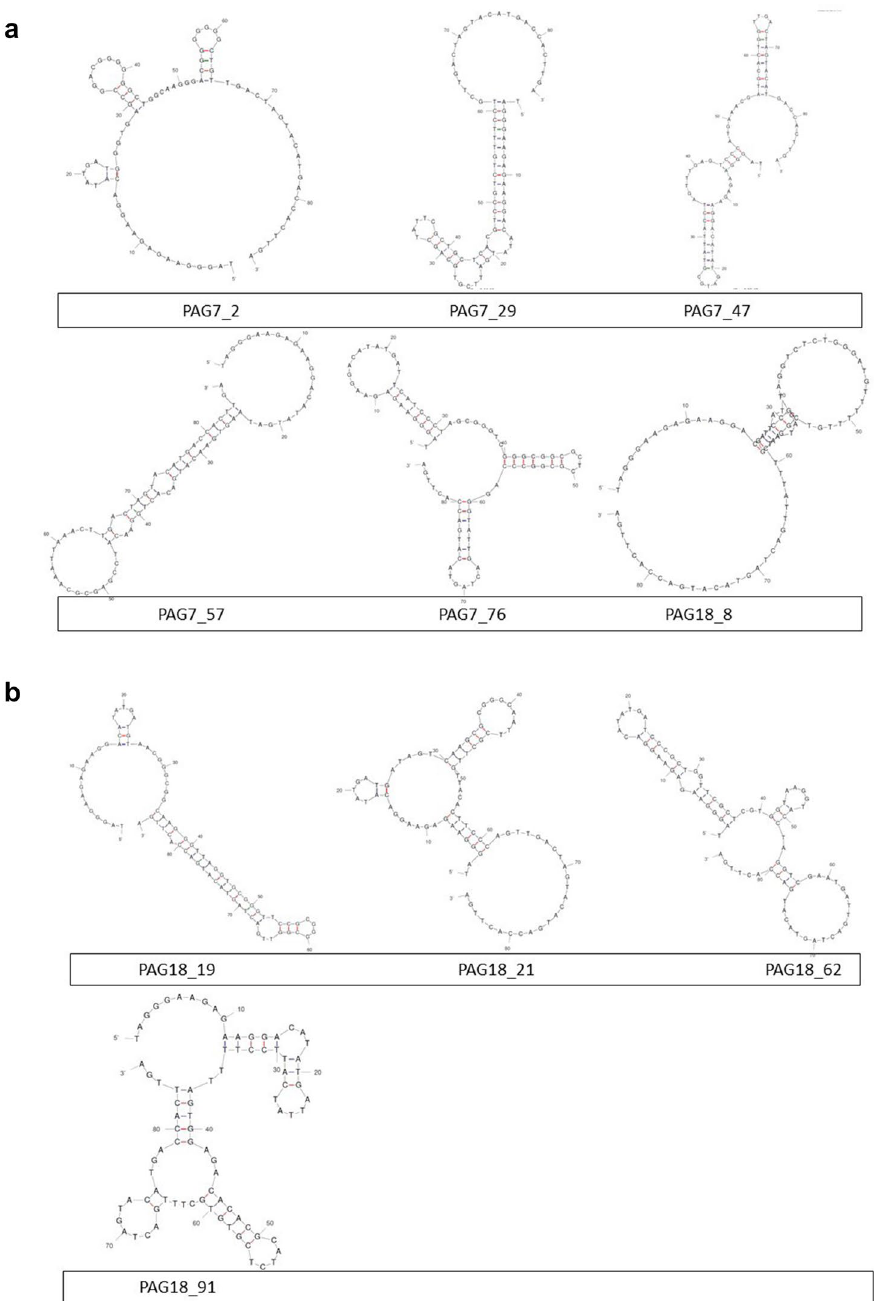
Figure 4. M fold structures of few selected